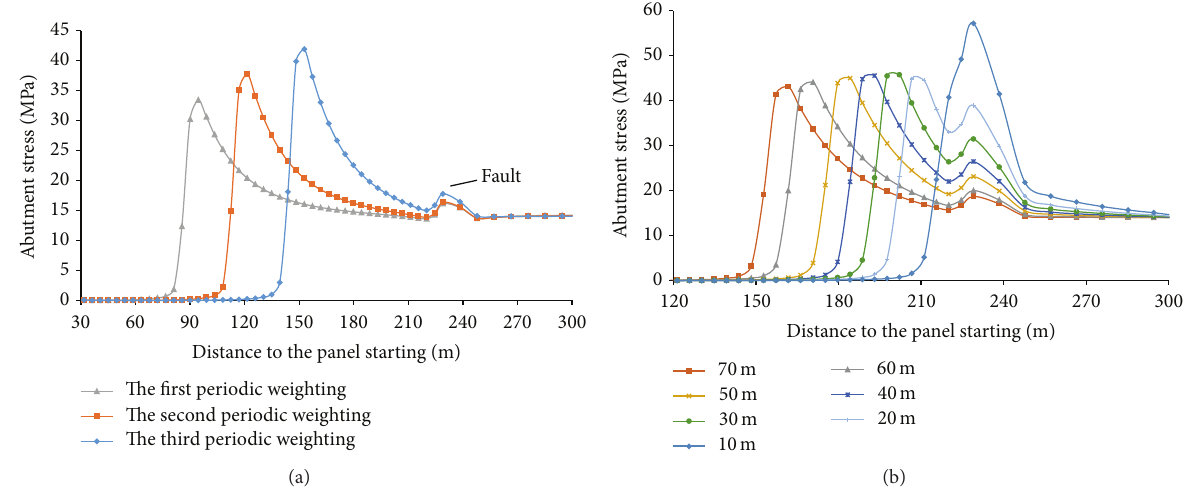
Figure 3: Abutment stress distribution of the panel along the strike: (a) during periodic weighting; (b) during mining in the fault area. Note that values in the boxes represent the distance between the panel and the